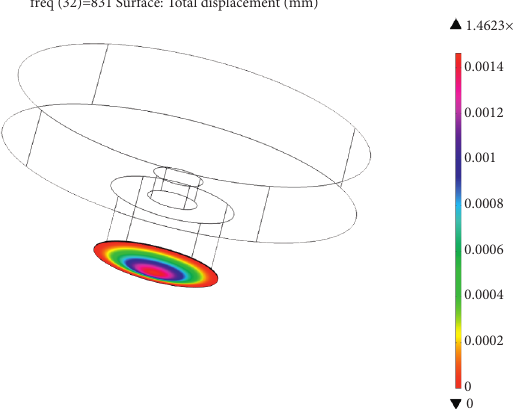
Figure 11: Displacement of piezoelectric circular plate with Helmholtz